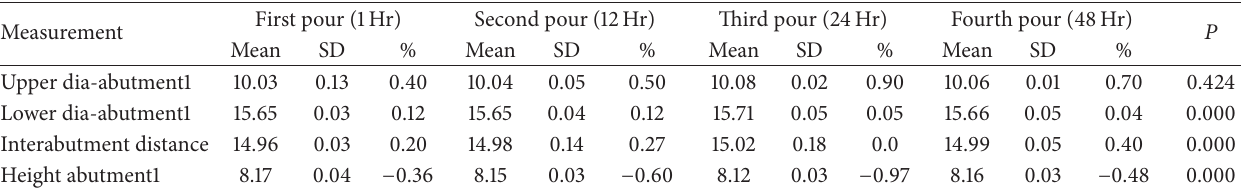
Table 1: The mean measurement values of stone dies, standard errors, and percentage of errors from master cast from putty reline impression technique.